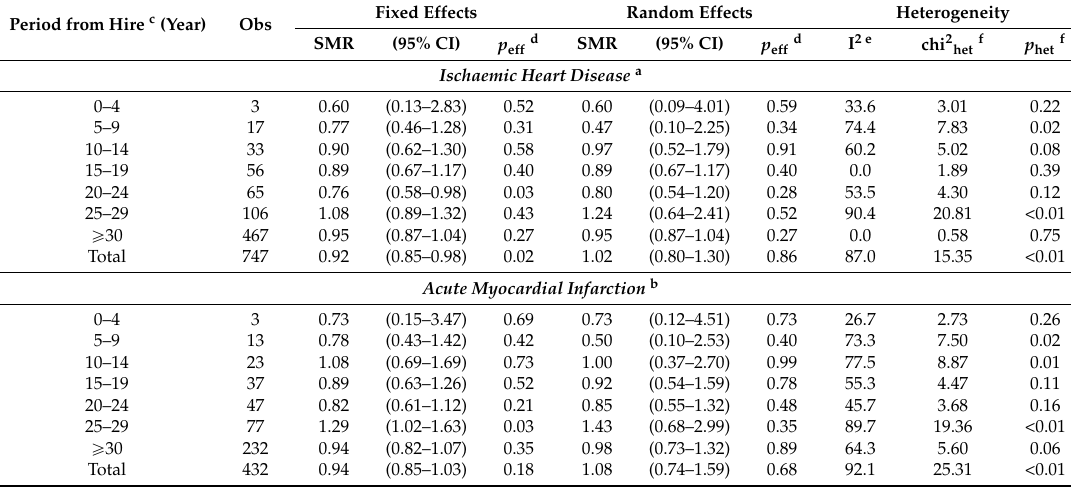
Table 4. Meta analyses of standardised mortality ratios (SMRs) for cardiac a,b mortality based on national rates by period from hire, in carbon black production workers of three full cohorts combined (US, UK,